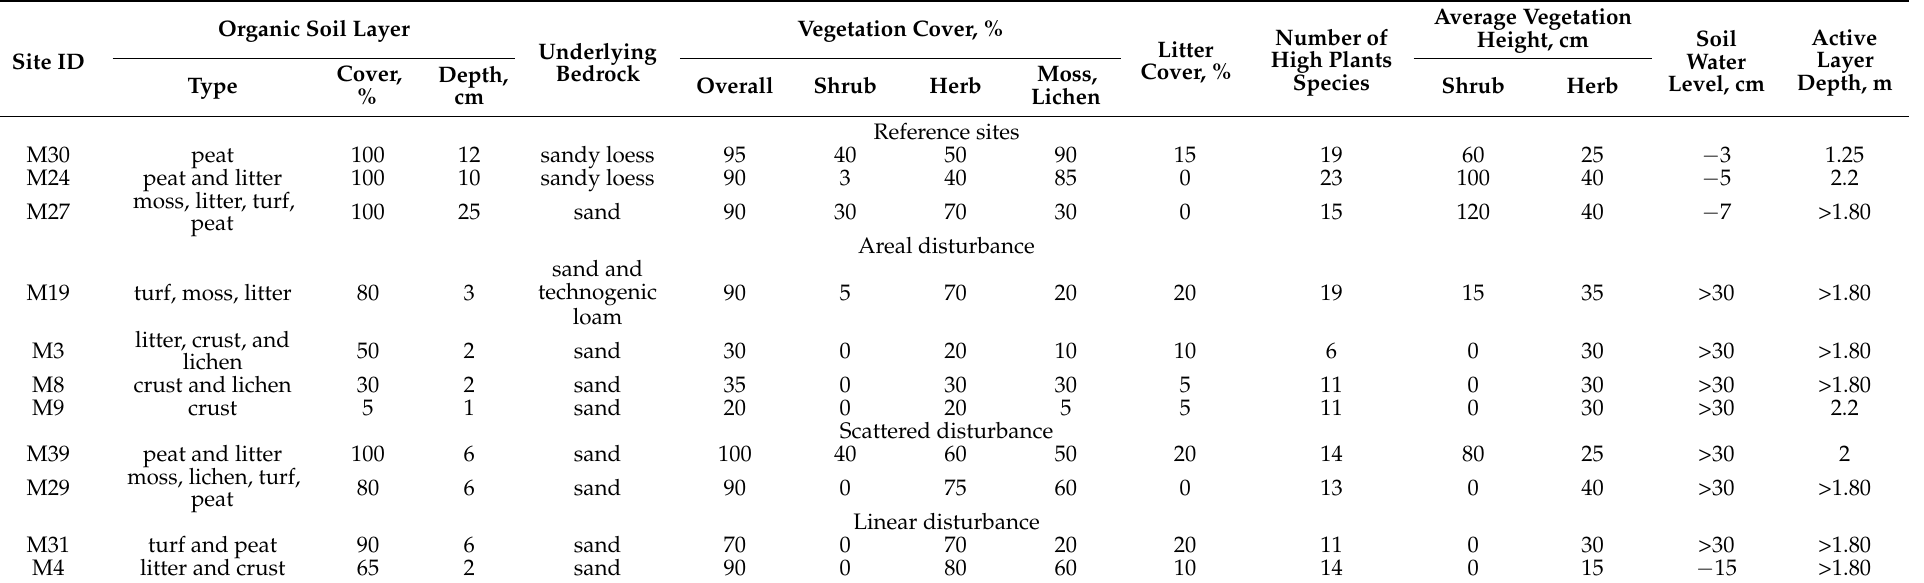
Table 2. Descriptive characteristics of soil profile and vegetation cover of the sampling